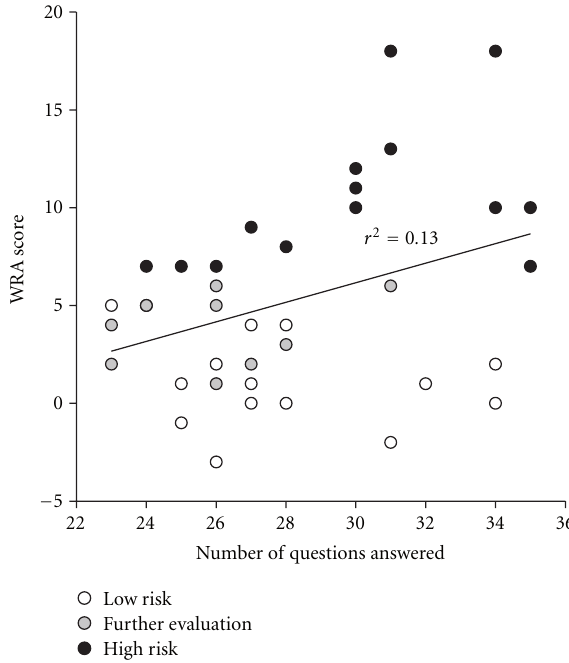
Figure 2: Relationship between the number of questions answered and the WRA score for Eucalyptus taxa